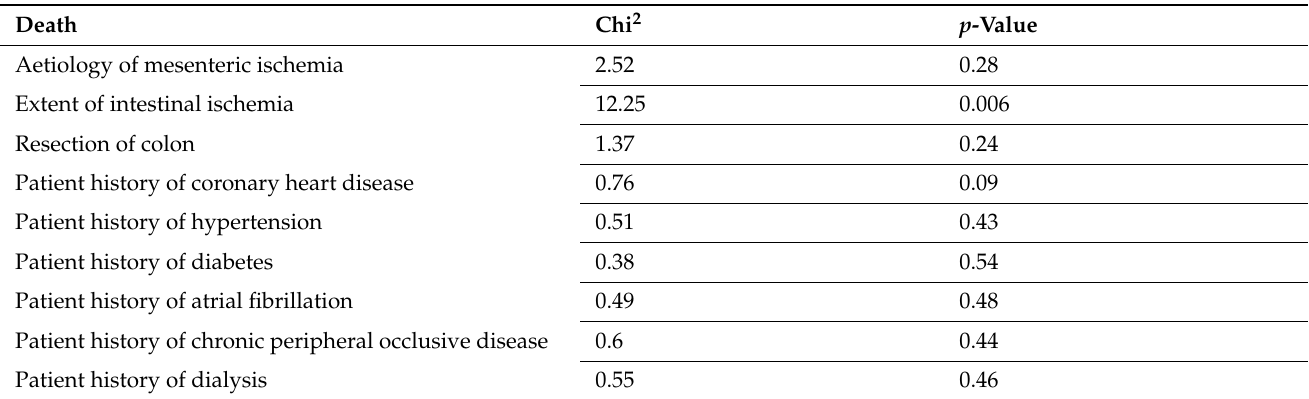
Figure 6. Kaplan–Meier estimate of the aetiology of mesenteric ischemia and patient death. The green line represents dissection, the blue line represents embolus and the red line represents thrombosis. Chi 2 = 12.25, p = 0.006; x -axis: months; y -axis: probability of survival. Table 5. Log-rank test between several clinical parameters and death. All parameters were obtained as part of the treatment regimen for mesenteric ischemia.